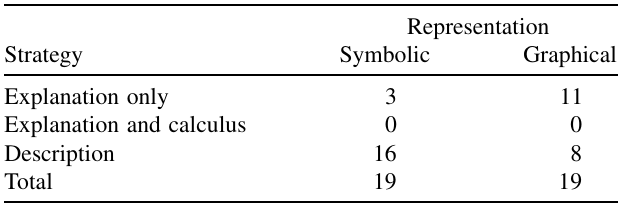
TABLE IV. Strategy when formulating a qualitative response from symbolic and graphical representations in